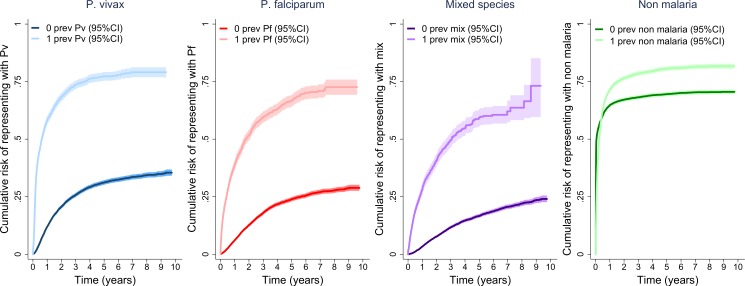
Kaplan-Meier curves showing the cumulative risk of re-presentation with a recurrent episode due to the same Plasmodium species.Abbreviations: prev; previous, Pv; Plasmodium vivax, Pf; Plasmodium falciparum, mix; mixed Plasmodium species infection, 95%CI; 95% confidence interval.